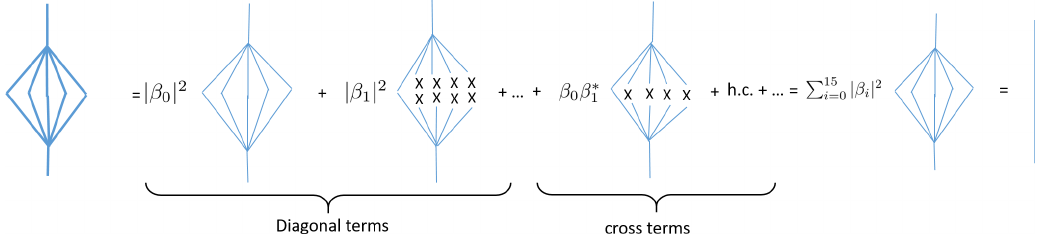
Figure 56. The imperfect tensor (bolded line) contraction can be computed term by term. For diagonal terms, they are simply the perfect tensor contraction, which reduce to identity. The cross terms vanish by orthogonality.